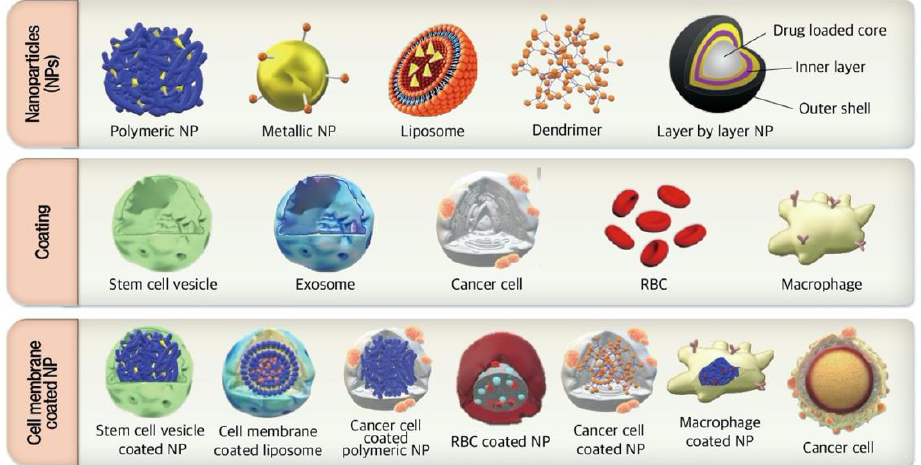
Figure 1. General scheme of membrane-coated nanoparticles (NPs). Different source of cancer cells or immune cells are applied as the shell of NPs by camouflaging different membranes. The membranes of cancer cells or immune cells are isolated from their source cells and extruded to obtain membrane vesicles. The vesicles then fuse with different types of NPs as a core to form membrane-camouflaged NPs. RBC, red blood cell.